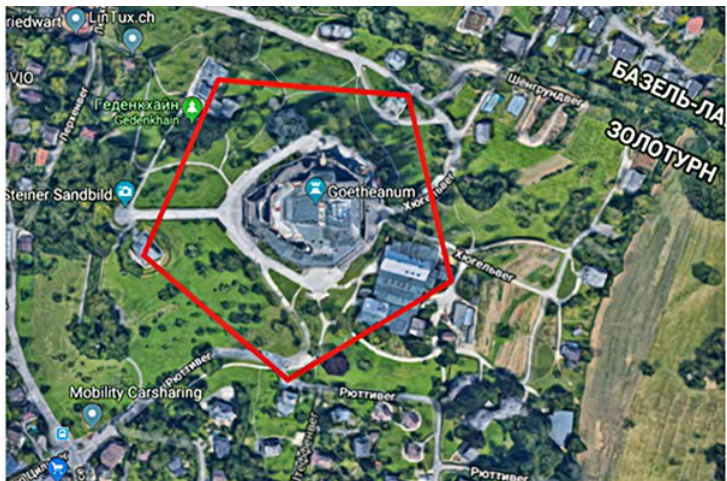
Figure 3. Goetheanum and ancillary structures.